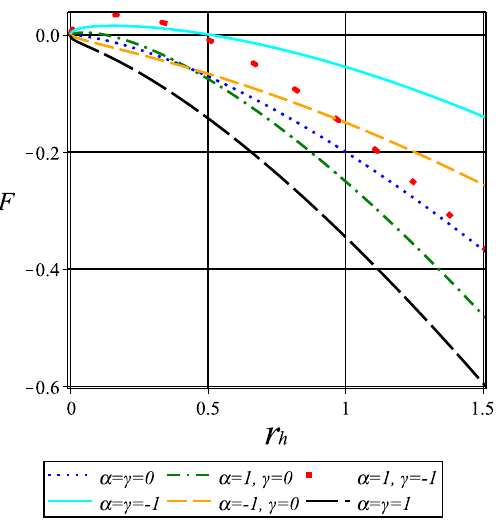
Fig. 7 Specific heat of LMP solution in hyperbolic space in terms of the black hole horizon for l = 1 and a = 10